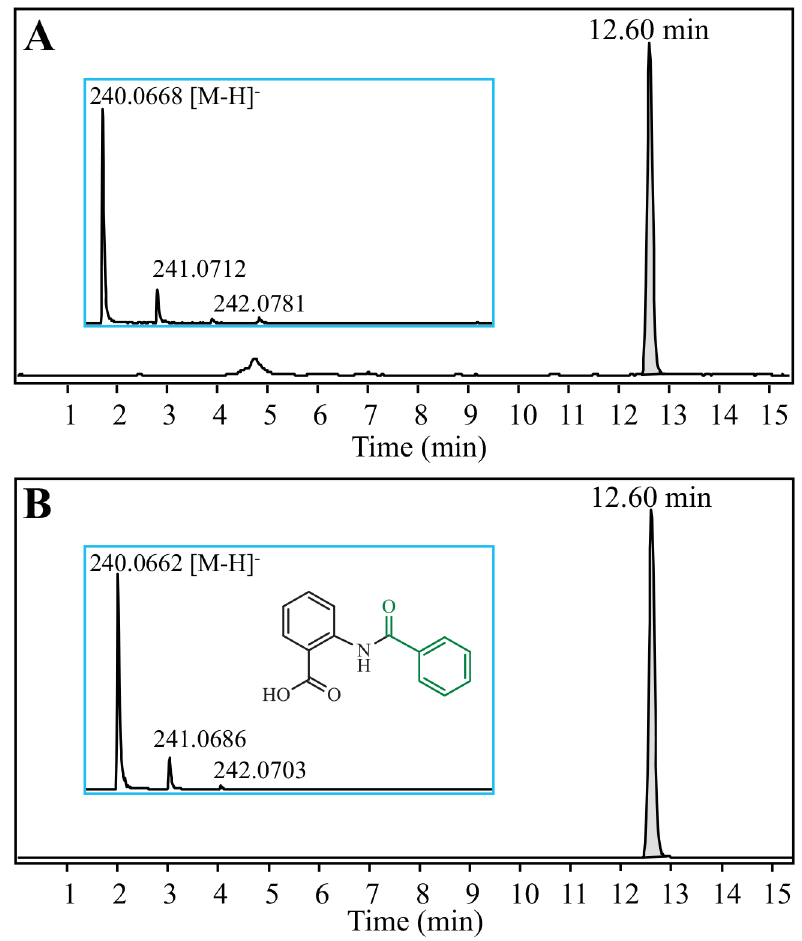
Fig 4. Detection of N -(benzoyl)-anthranilate (dianthramide B) from the recombinant yeast culture medium. Representative ESI-MS spectra were obtained after LC-TOF MS analysis of (A) the culture medium of recombinant yeast incubated with anthranilate and benzoic acid, and (B) a dianthramide B standard